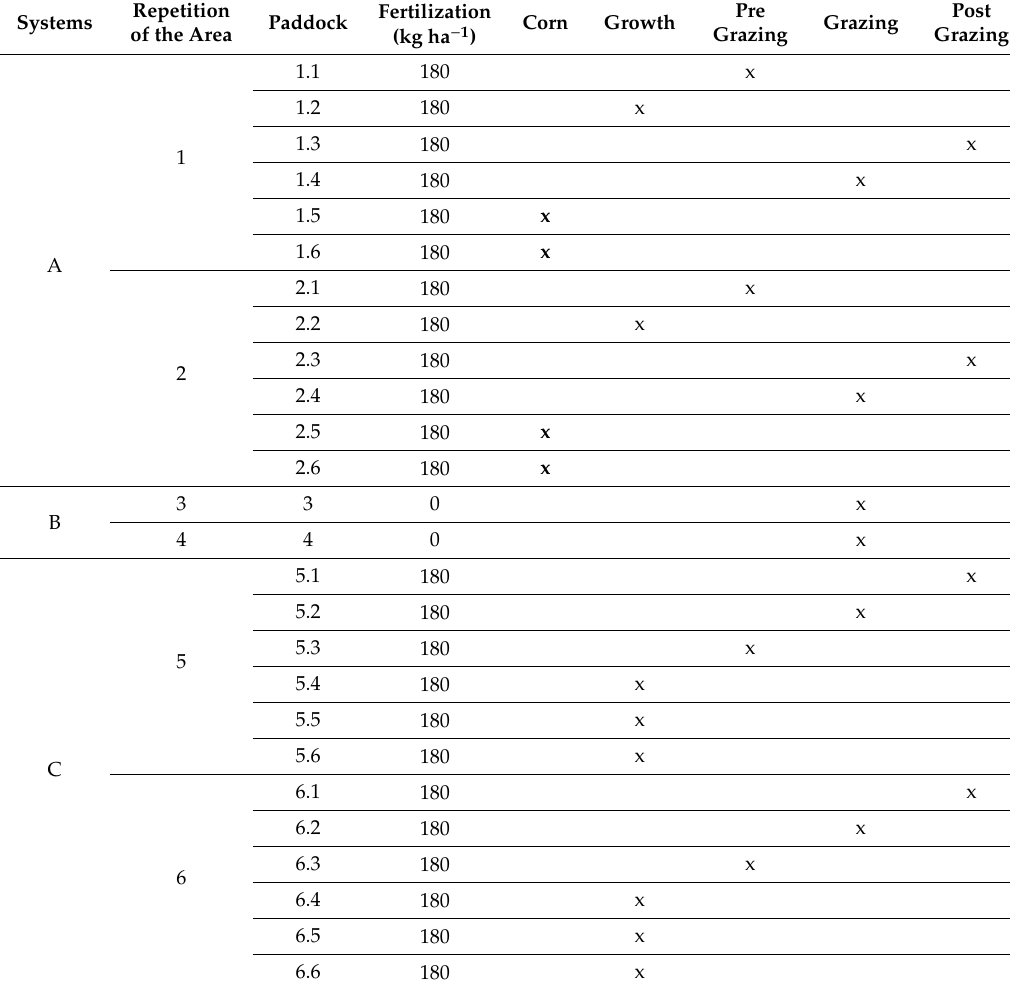
Table 4. State of development and fertilization of the Piat ã and Decumbens grass pasture in the production systems (A, B and C), on 25 April 2018. Corn = areas under maize cultivation in iCL systems; growth = paddocks in regrowth in areas under rotated management; pre-pasture = paddocks just before the animals enter the areas under rotated grazing; grazing = paddocks being grazed by the animals; post-grazing = paddocks soon after the animals leave rotating grazing areas. Post Pre Repetition Fertilization Grazing Paddock Corn Growth Systems Grazing of the Area (kg ha − 1 )